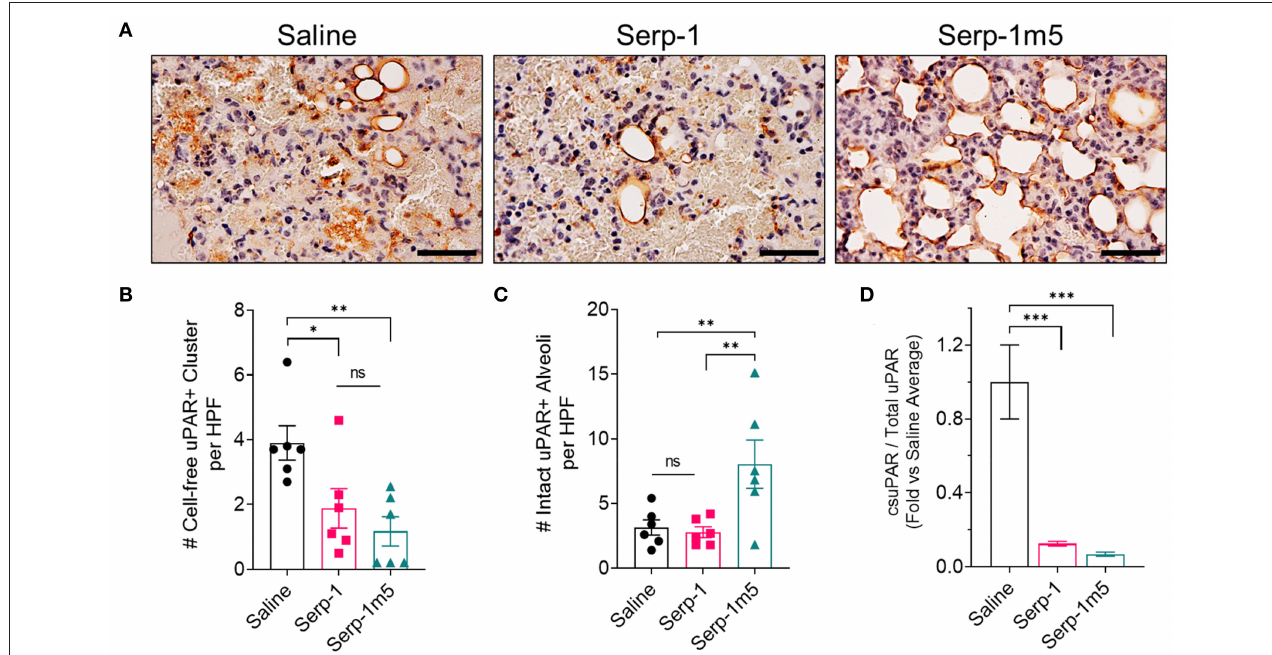
FIGURE 9 | Serp-1 and Serp-1m5 treatment reduce soluble uPAR in the pristane-induced DAH model. (A) The representative pictures of uPAR IHC staining. (B) Serp-1 and Serp-1m5 reduced cell-free uPAR + clusters in IHC staining when compared to the saline treatment group (Serp-1, p = 0.0172; Serp-1m5, p = 0.0025). (C) Serp-1m5 increased intact uPAR + stained alveoli along the inner rim when compared to the saline treatment group ( p = 0.0091; Serp-1m5 vs. saline). (D) The ratio of csuPAR to total uPAR of Serp-1 and Serp-1m5 tested by ELISA of lung tissue was significantly lower than that of the saline group (Serp-1, p = 0.0004; Serp-1m5, 0.0002). * p < 0.05, ** p < 0.01, and *** p <